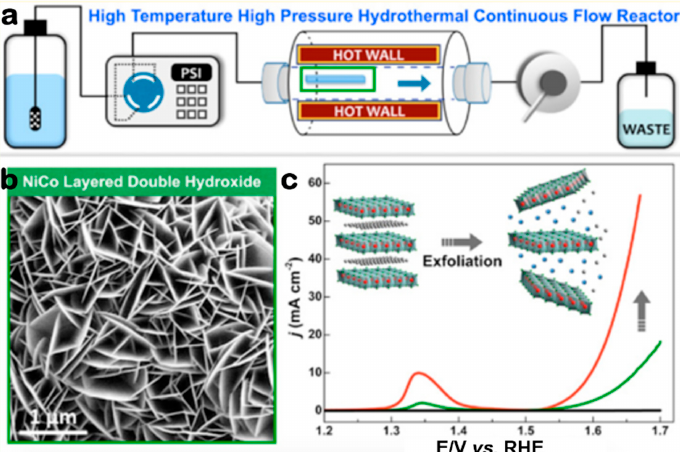
Figure 17. ( a ) The high-temperature high-pressure continuous flow reactor (HCFR) scheme; ( b ) scanning electron microscope (SEM) image of exfoliated NiCo LDH from HCFR; ( c ) iR -corrected and background subtracted polarization curves (anodic sweep) of NiCo LDH nanoplates (green curve) made of HCFR with mass catalyst loading of ~0.23 mg cm − 2 , NiCo LDH nanosheets (red curve) synthesized nanoplates from exfoliated HCFR with a mass catalyst loading of ~0.17 mg cm − 2 , and carbon paper (black curve) in O 2 -saturated 1 M KOH at a scan rate of 0.5 mV s − 1 . All experiments were conducted at room temperature (25 °C). Reproduced from [160], Copyright © American Chemical Society, 2015.